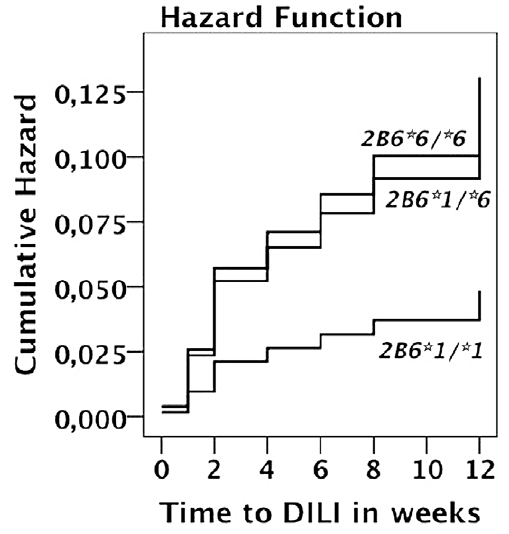
Figure 2. Kaplan-Meier curves indicating estimate cumulative hazard for the development of drug induced liver injury between the different CYP2B6*6 genotypes in patients receiv- ing efavirenz based HAART with or without rifampicin based anti-TB therapy during the first three months of follow up